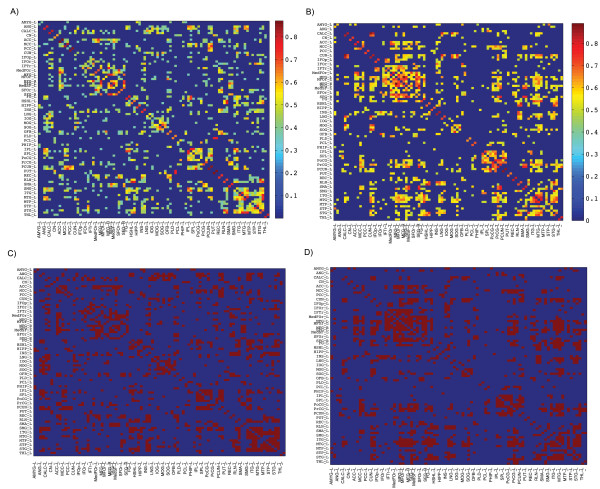
Association and binary adjacency matrices; association matrices for (A) BC and (B) CON groups, binary adjacency matrices for (C) BC and (D) CON groups (connected regions are shown in red). The association matrices show the highest connectivity between regions of interest as well as for inter-hemispheric regions.